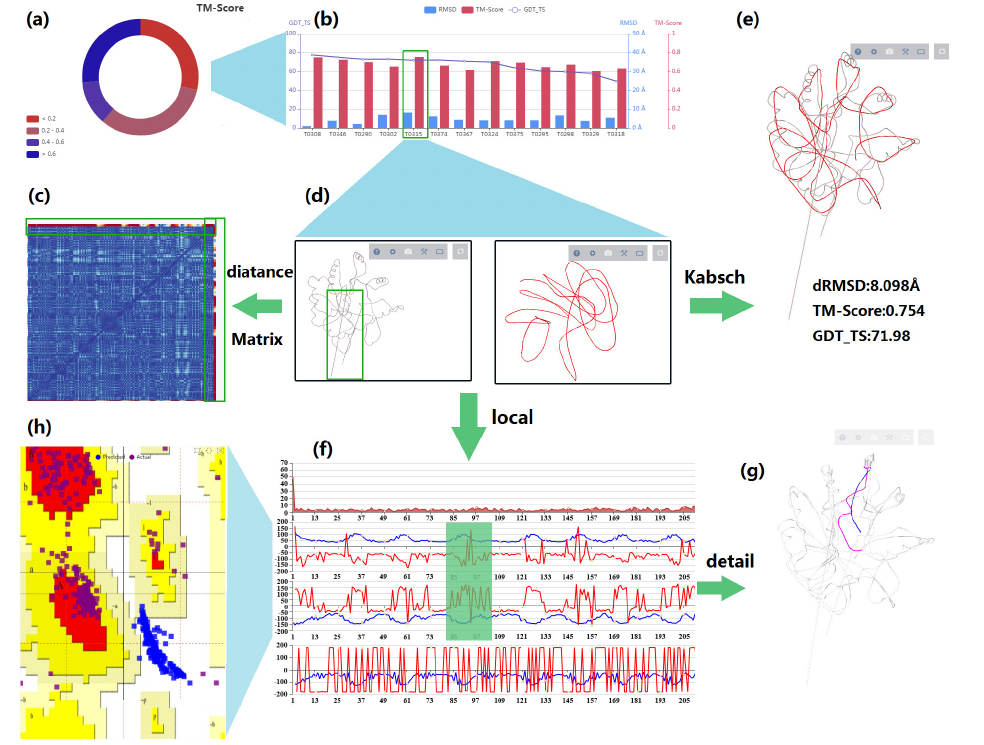
Figure 11. Multi-level analysis of the basic process of